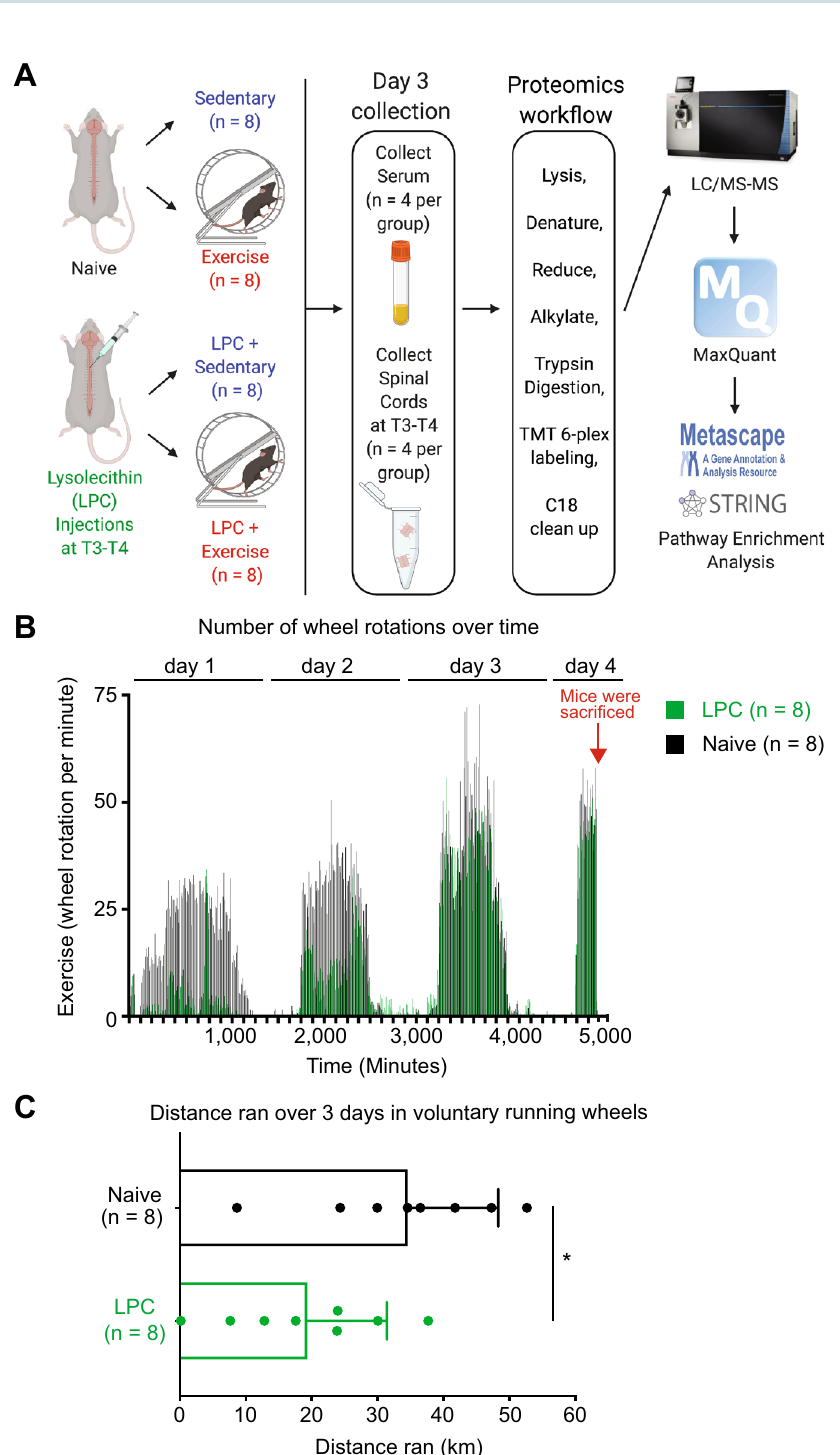
Figure 1. Workflow and running wheel activity. The LPC mice recovered for ~ 1–2 h post-surgery and the same rest period was given to naïve mice. Naïve and LPC animals were given access to a running wheel, or a wheel on its side immediately following recovery. ( A ) Schematic demonstrating experimental workflow. Animals were subjected to LPC surgery or not, then housed with an unlocked or locked running wheel. Serum and tissue were collected on the 4th day (4 h into the running cycle) and subjected to a quantitative shotgun proteomics workflow. Spinal cords and serum were pooled in groups of 2 for adequate protein concentrations (n = 4 of 2 pooled samples, n = 8 total). Figure was drawn using BioRender. The data was analyzed using the freely available MaxQuant software v.1.6.0.1 (https:// www. maxqu ant. org). ( B ) Running wheel data of naïve and LPC mice. Revolutions were monitored and binned in 10-min increments. Figure was drawn using Prism. ( C ) Quantification of total distance run over a 4-day period for naïve (n = 8) and LPC (n = 8) mice. Student’s t -test was used for statistics. * P < 0.05